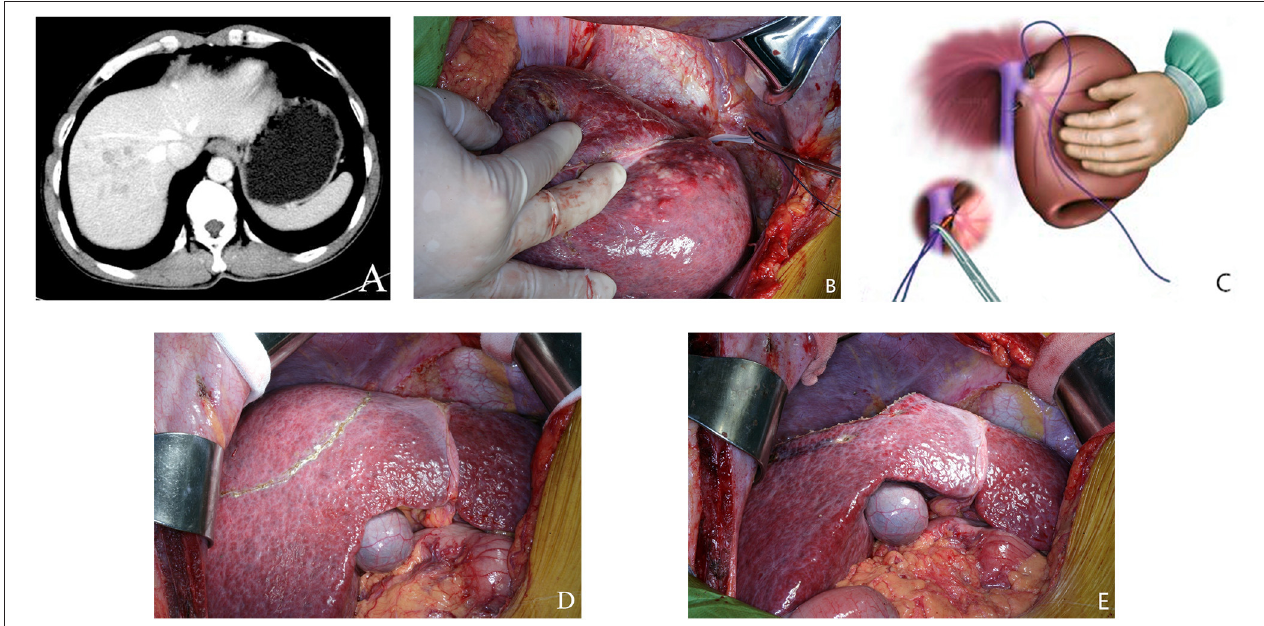
FIGURE 1 | (A) Preoperative CT scan of liver. The tumor was located within segment 7–8. (B) A new technique using intraoperative ultrasound to guide a blunt needle and a suture to ligate the right hepatic vein. (C) A schematic diagram on this maneuver. (D) The extent of hepatic resection was shown in the figure. A transection line is positioned on the right side of the middle hepatic vein (MHV) and along the segment 5 branch to preserve them. (E) Raw liver surface at the end of bisegmentectomy